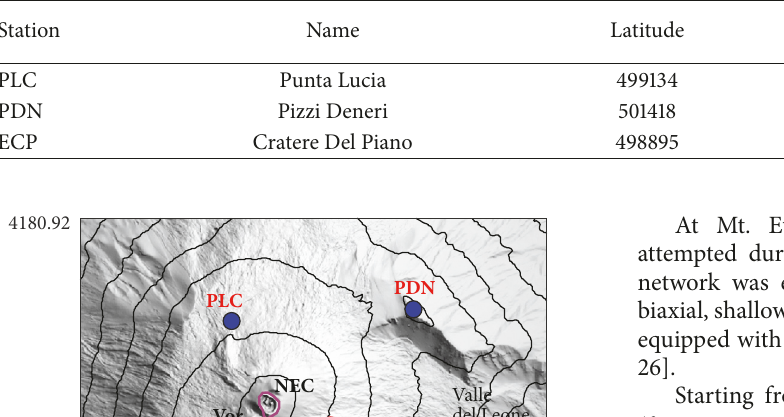
Table 1: Coordinates (UTM, in m) of the three summit tilt stations.